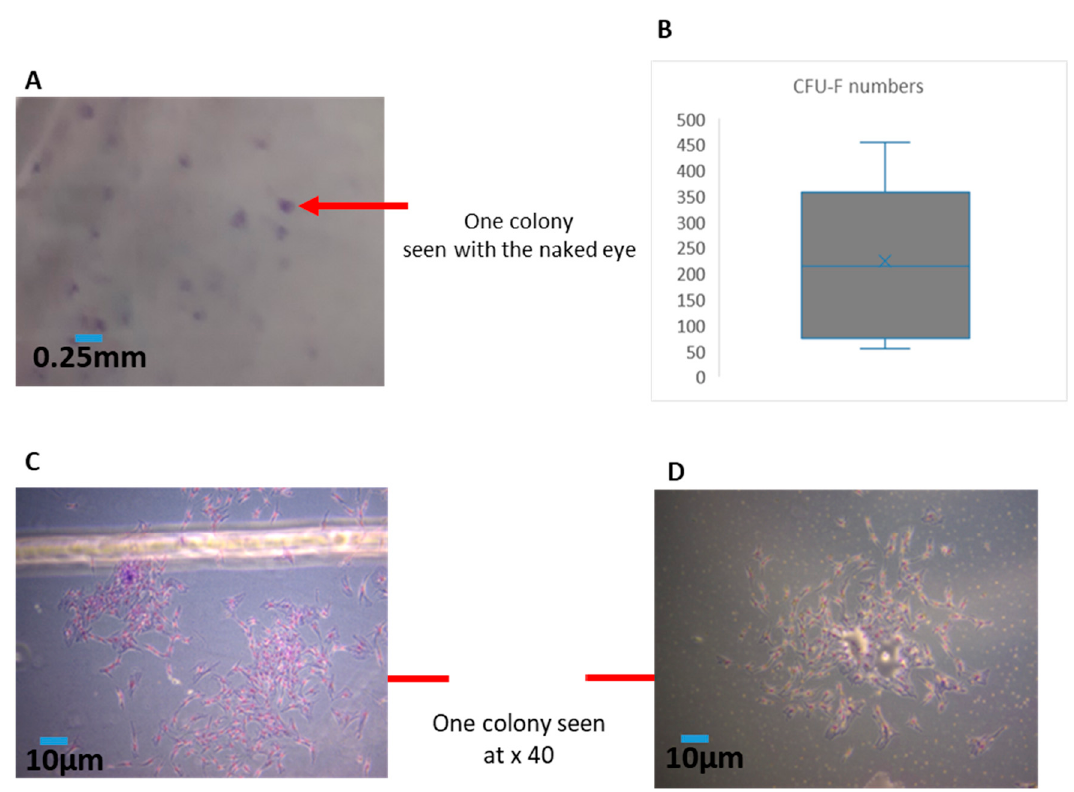
Figure 2. The numbers of fibroblastoid colony-forming unit (CFU-F) colonies of 0.25 mL of MFAT from the six patients in Figure 1 indicated a large variation. A total of 0.25 mL MFAT was digested with collagenase in MEM α and then cultured in a MEM α complete medium for 10 days, stained with Giemsa and fixed with 100% methanol. ( A ); shows colonies observed with the naked eye. ( B ); the mean numbers of colonies ± SD. ( C , D ) show the magnified appearance of an individual colony under microscopy (×40).